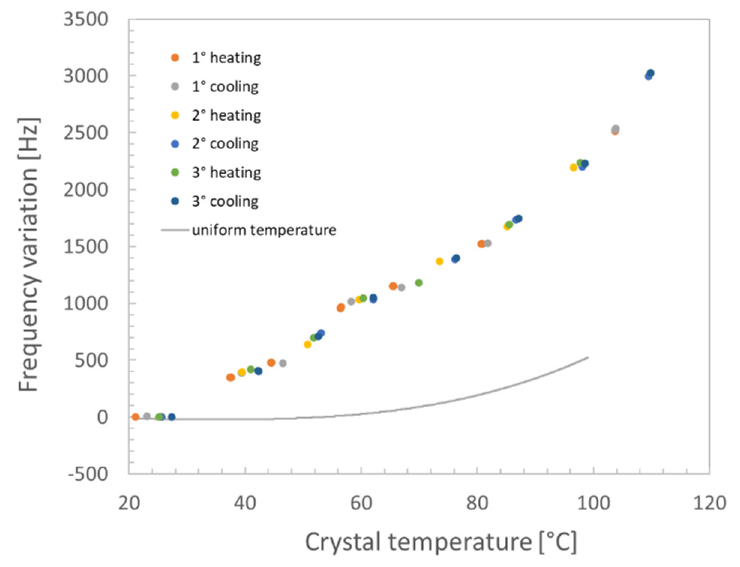
Figure 10. Measured frequency variation with the localized heating of the crystal and the uniform temperature condition.